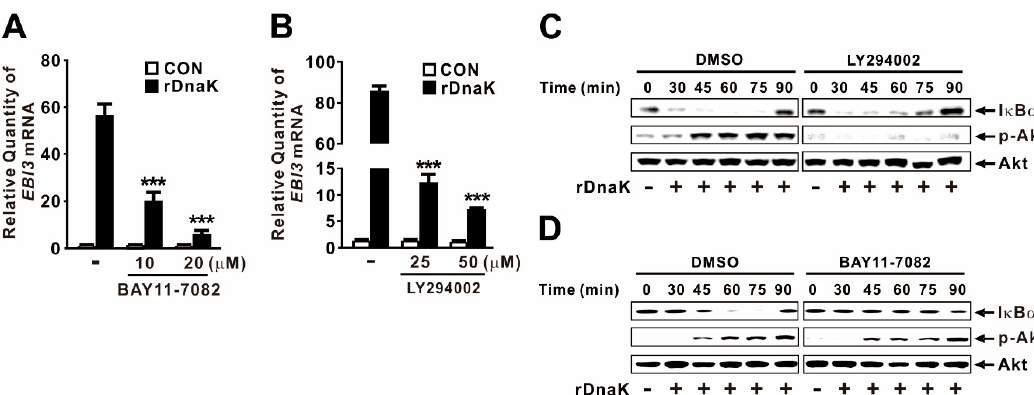
Figure 5. DnaK-induced expression of EBI3 is under the control of the NF- κ B and Akt signaling pathways. ( A , B ) dTHP-1 cells were pretreated with either BAY11-7082 ( A ) or LY294002 ( B ) at the indicated concentrations for 1 h followed by the treatment with rDnaK (1 μ g/mL) for 4 h. ( C , D ) dTHP-1 cells were pretreated with either 50 μ M LY294002 ( C ) or 20 μ M BAY11-7082 ( D ), followed by treatment with rDnaK (1 μ g/mL) for the indicated times. After treatment, mRNA levels of EBI3 were measured by qRT-PCR ( A , B ), and protein levels were analyzed by immunoblotting ( C , D ). Data in A - B are expressed as means ±SD ( n = 3). Data in ( C , D ) are representative of three separate experiments. ***, p < 0.001 vs. no treatment with inhibitor ( A , B ).